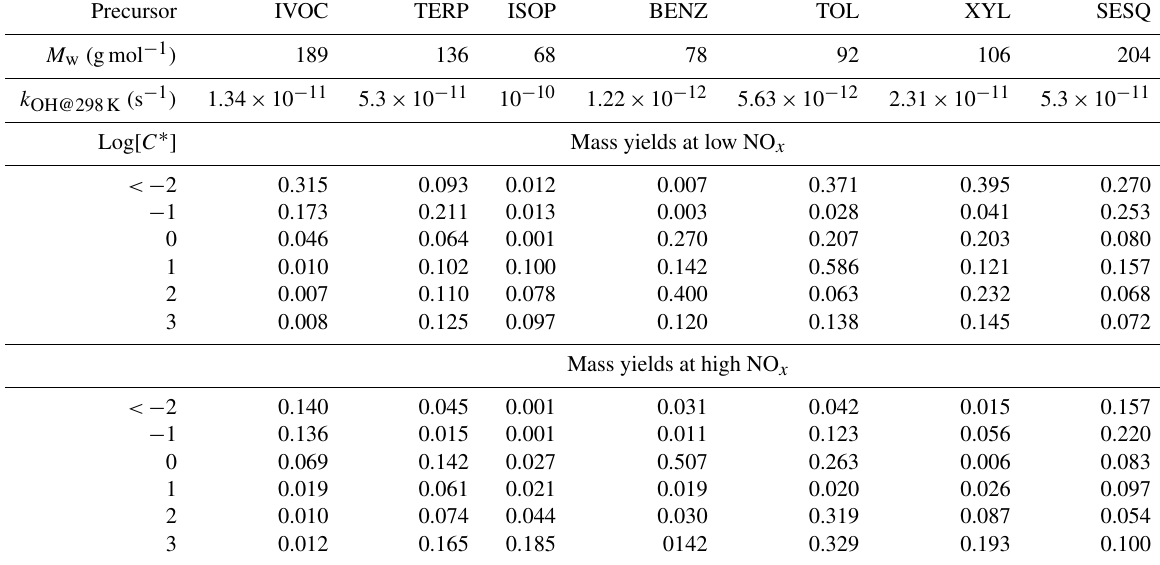
Table 1. Parameters used in the new volatility basis set (VBS_NEW). Wall-corrected mass yields are based on the Statistical Oxidation Model (SOM) fit to the chamber data from Zhang et al. (2014). For isoprene, an isoprene-specific version of SOM was used (see Supplement for details). IVOC yields are derived from the explicit model GECKO-A simulations performed for n-alkanes mixtures at low (0.1ppb) and high (10ppb) NO x levels. For SOM and GECKO-A fits, yields were derived assuming background OA concentrations of 10µgm − 3